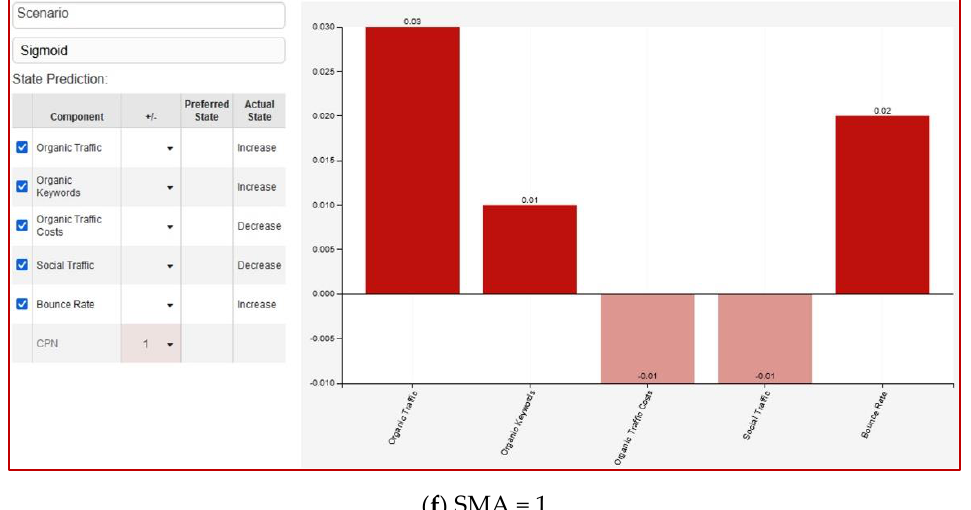
Figure 3. The results of the concept map (FCM) present correlations between variables. This figure presents three phases of the model depending on war crisis cases. ( a ) presents lower cases, ( b – e ) present medium cases, and ( f ) presents higher cases of the war crisis.